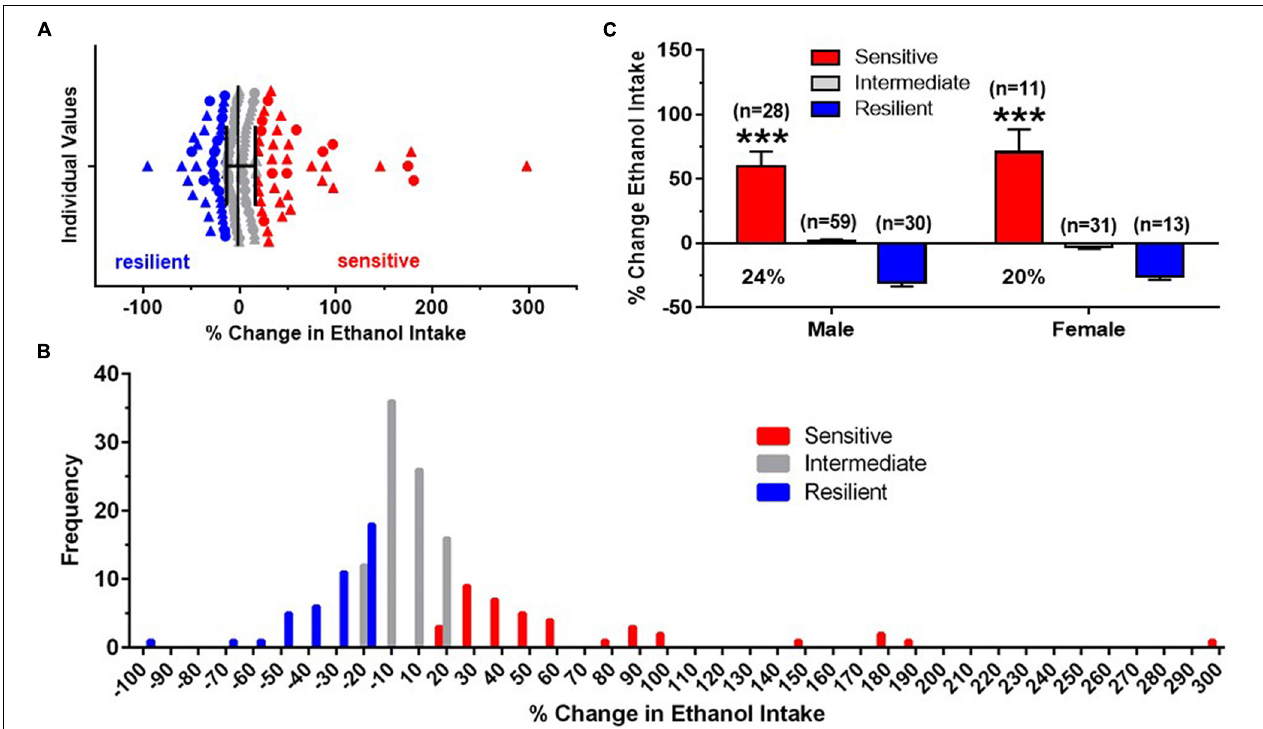
FIGURE 2 | Identification of “sensitive” and “resilient” subgroups. (A) Horizontal scatterplot of the distribution of percent (%) change in baseline (BL) ethanol drinking after four predator stress (PS) exposures, with median and interquartile ranges for male (triangles) and female (circles) C57BL/6J mice. Mice chosen for the “sensitive” (red) and “resilient” (blue) subgroups were the extremes of the distribution and did not include animals in the middle (gray, “intermediate”). (B) Frequency distribution histogram for the % change in BL ethanol drinking after intermittent PS further illustrate the distinct “sensitive” and “resilient” subgroups. (C) Mean ± SEM % change in ethanol intake data for the three subgroups, with the number of animals in each subgroup shown in parentheses. The proportion of mice in the “sensitive” subgroup is shown below the mean data for this group. Data for “intermediate” group are shown for informational purposes. Analyses were conducted across the “sensitive” and “resilient” subgroups. *** p < 0.001 vs. resilient